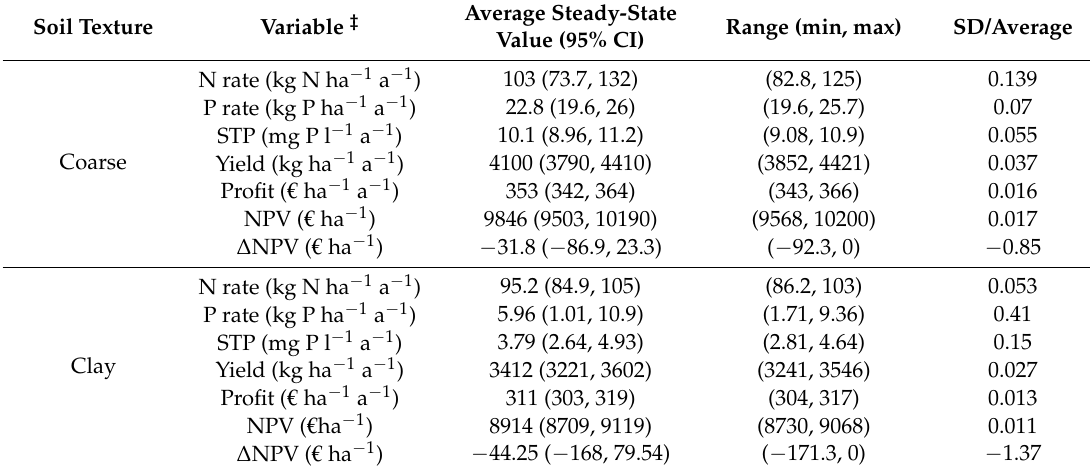
Table 6. Effect of the structural uncertainty on the robustness of the economic optimization results †